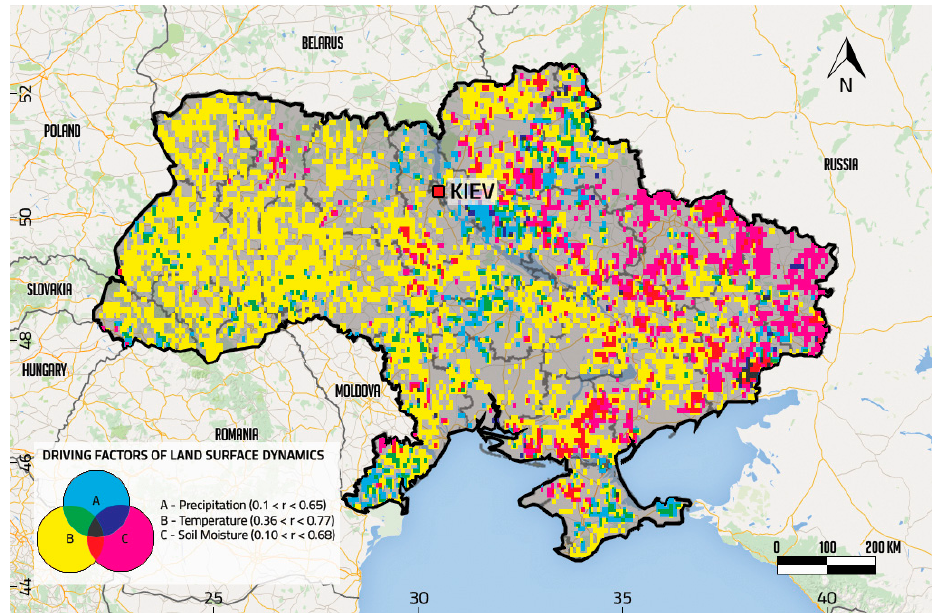
Figure 5. Dominant factors of Normalized Difference Vegetation Index (NDVI) change: pixel-wise correlation coefficients between NDVI and environmental variables. The graycolor denotes pixels without statistically significant correlations ( p < 0.05).